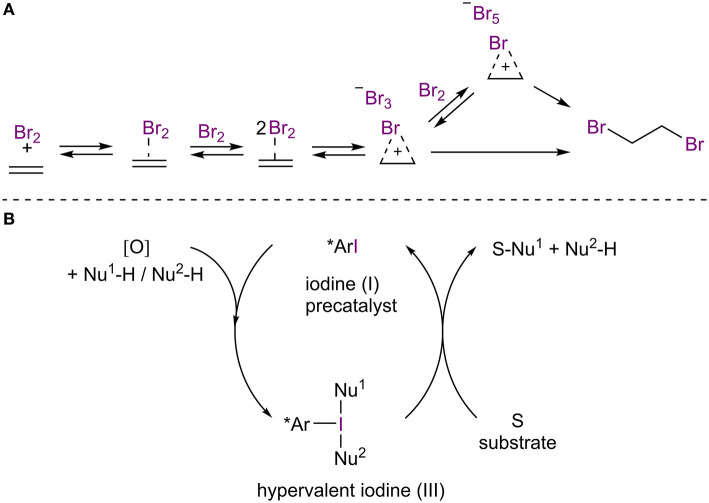
(A) Participation of XBs in the bromination of alkene; (B) general scheme of iodine(I/III)-enabled oxidative transformations.